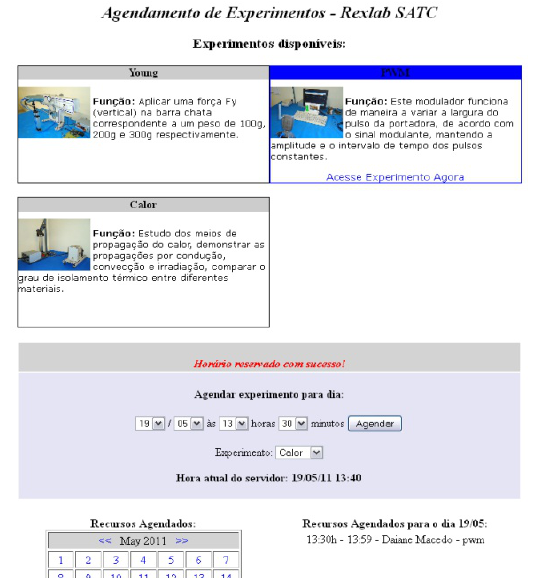
Figure 13. Layout of the scheduling page